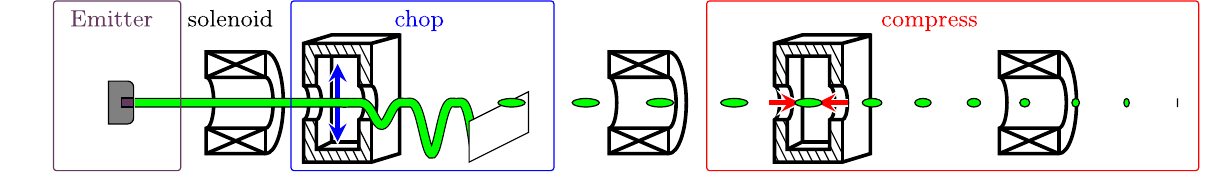
FIG. 1. Schematic view of the complete thermionic electron gun. The blue and red arrows depict the electromagnetic force on the green electron beam due to the time-dependent magnetic and electric field